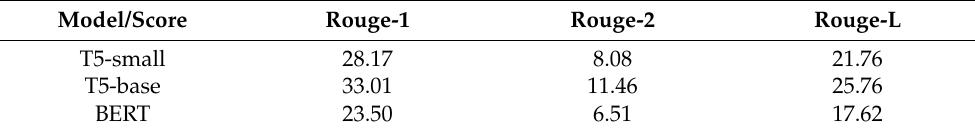
Table 2. Performance evaluation (output length: 80).